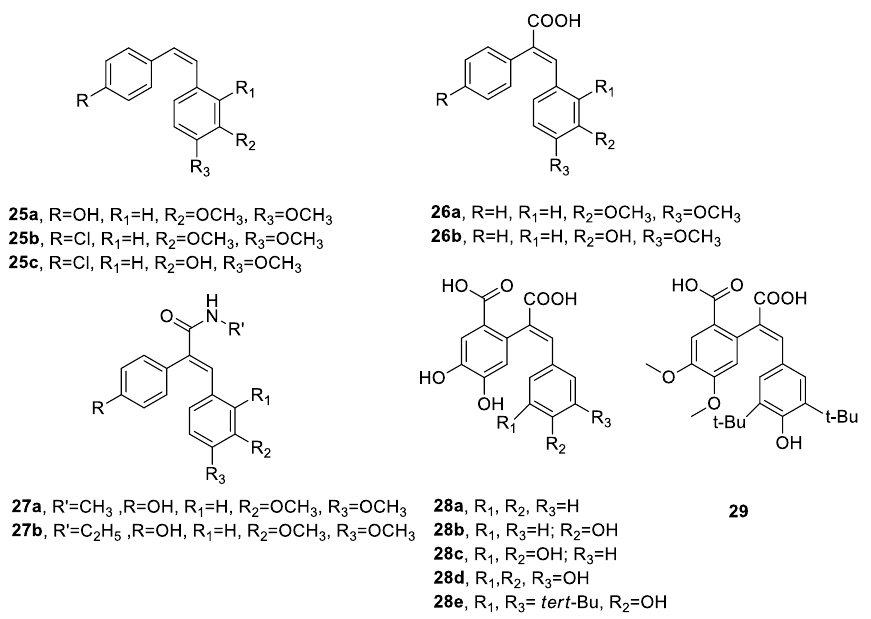
Figure 10. Structures of stilbene derivatives from Jain et al. (2015), Miliovsky et al. (2013), and More et al. (2015) [78 – 80].